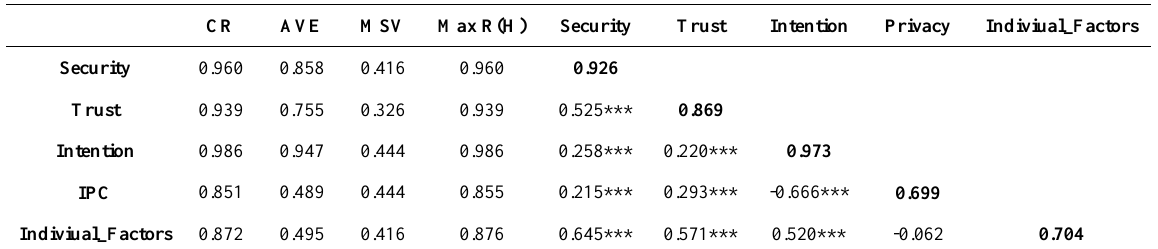
Table 2. Convergent & Discriminate